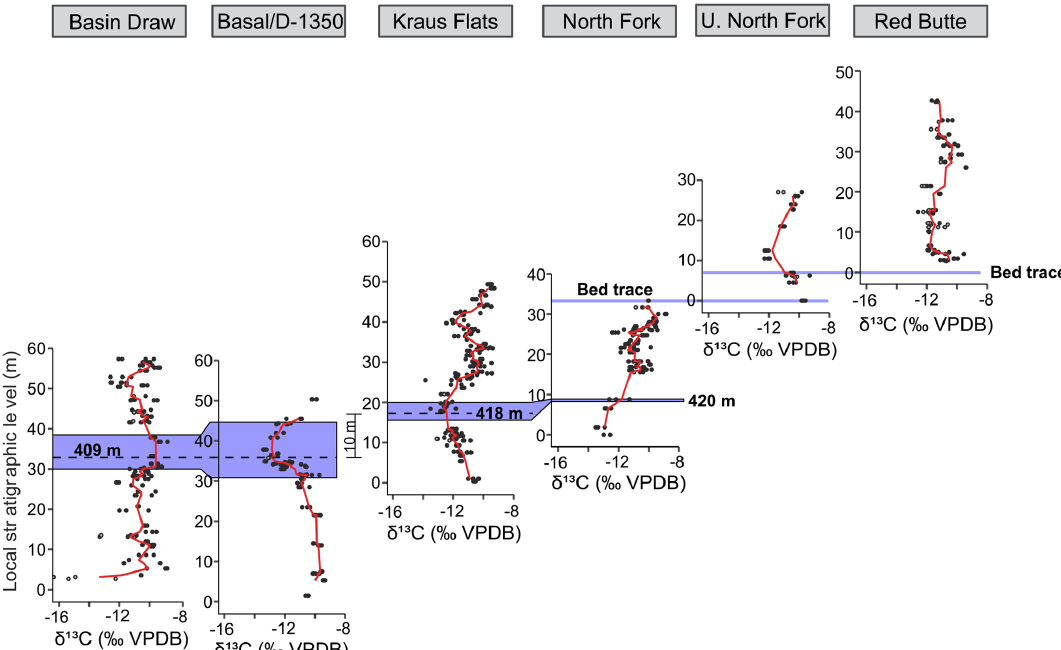
Figure A9. Section correlations based on bed traces and fossil locality levels. Stratigraphic levels represent meter levels measured using a Jacob’s staff. Bed traces are used to correlate between the North Fork and Upper North Fork sections and between the Upper North Fork and Red Butte sections. Fossil localities that occur at the 409 BCM level in the Basin Draw and Basal/D-1350 sections are used to correlate these sections. Fossil localities that occur near the 420 BCM level in the Kraus Flats and North Fork sections are used to correlate these sections, and the difference between these BCM levels helps tie the Basin Draw, Basal/D-1350, and Kraus Flats sections